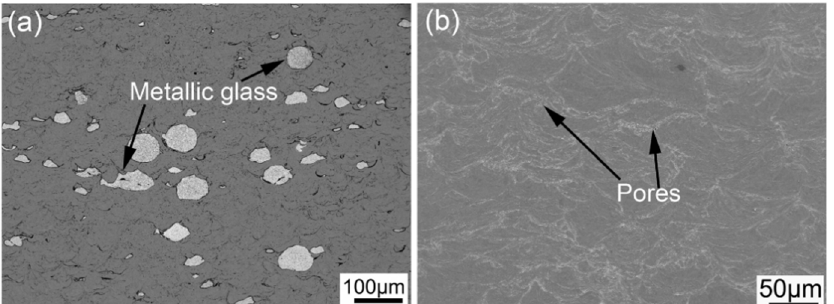
Figure 11. Cross-sectional microstructure of ( a ) composite deposits and ( b ) Cu deposits after chemical etching. Reprinted with permission from [45] Copyright 2021 Elsevier . etching. Reprinted with permission from [45] Copyright 2021